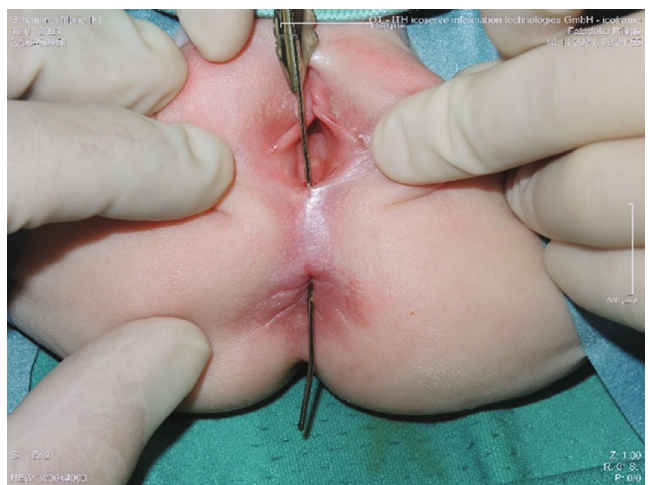
Figure 1: AVF (anovestibular fi stula) with a normal anus.